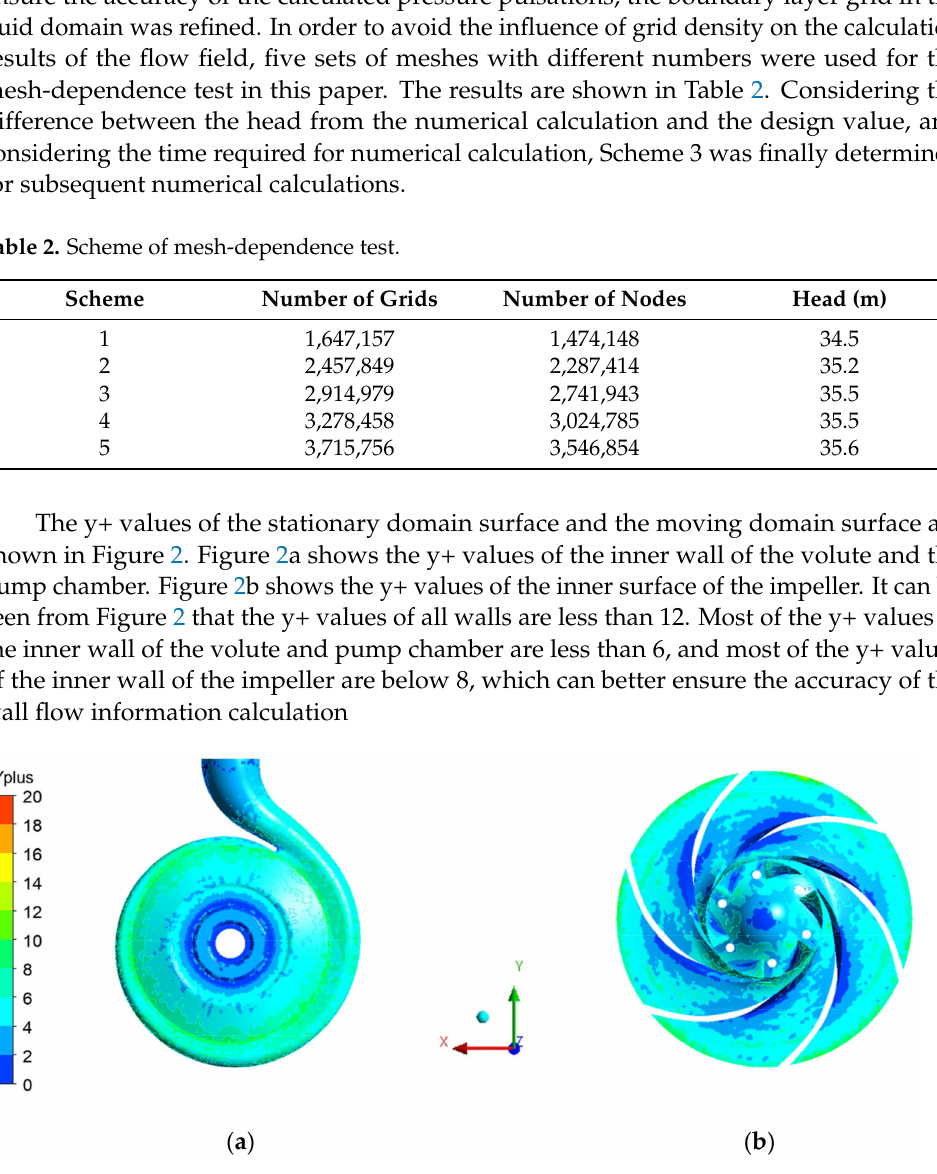
Figure 2. y+ distribution of the volute, pump chamber, and impeller: ( a ) static